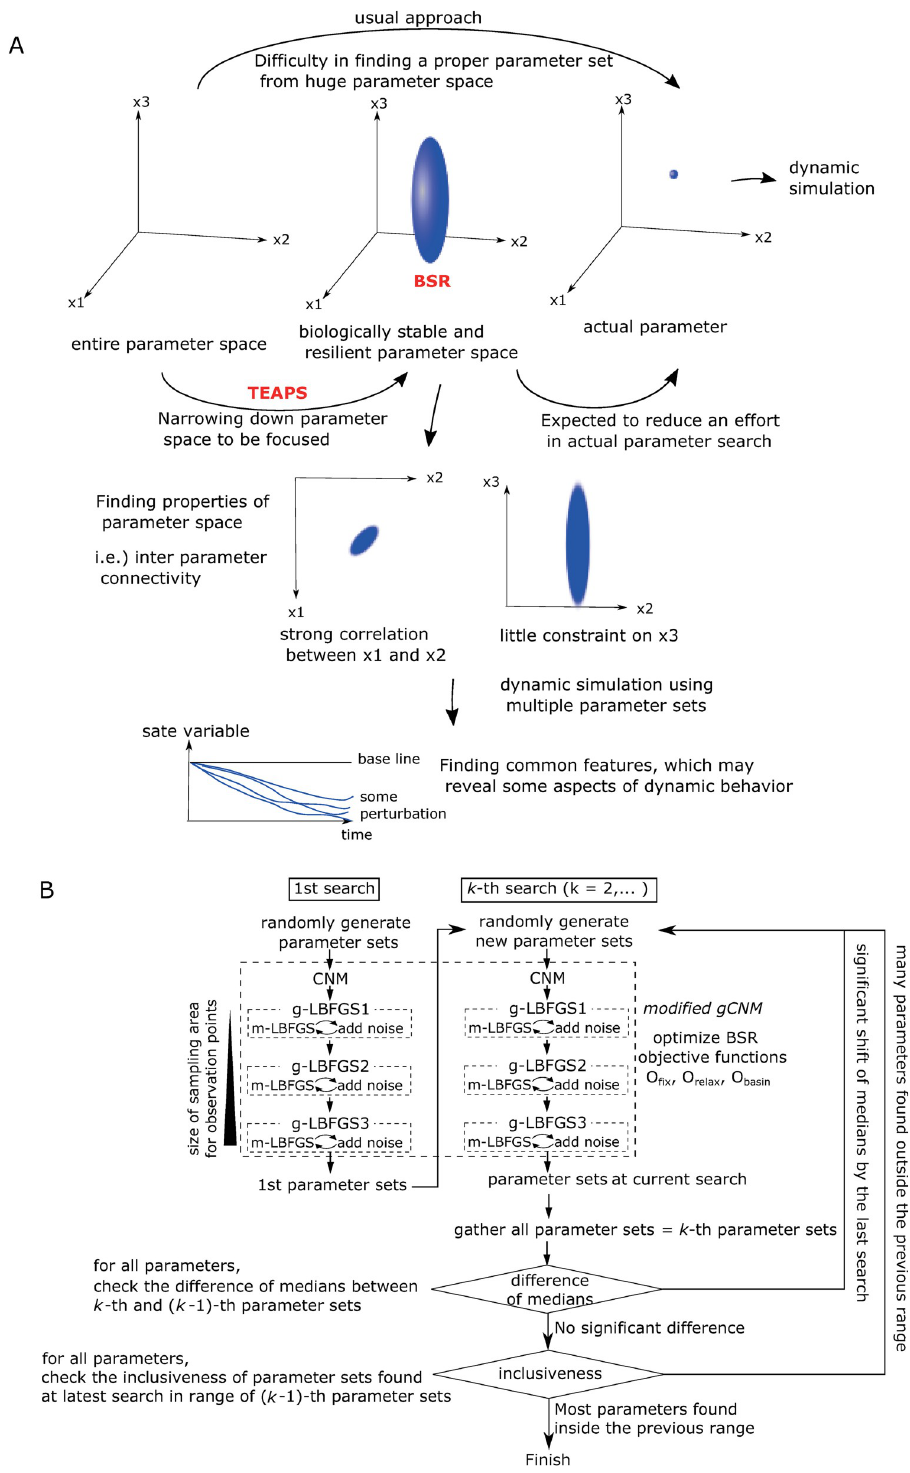
Fig 2. Advantages of focusing BSR and framework of TEAPS. (A) Advantages of focusing BSR were depicted. See detail in the text. (B) The framework of thorough exploration of parameter sets satisfying the BSR constraints, which we named